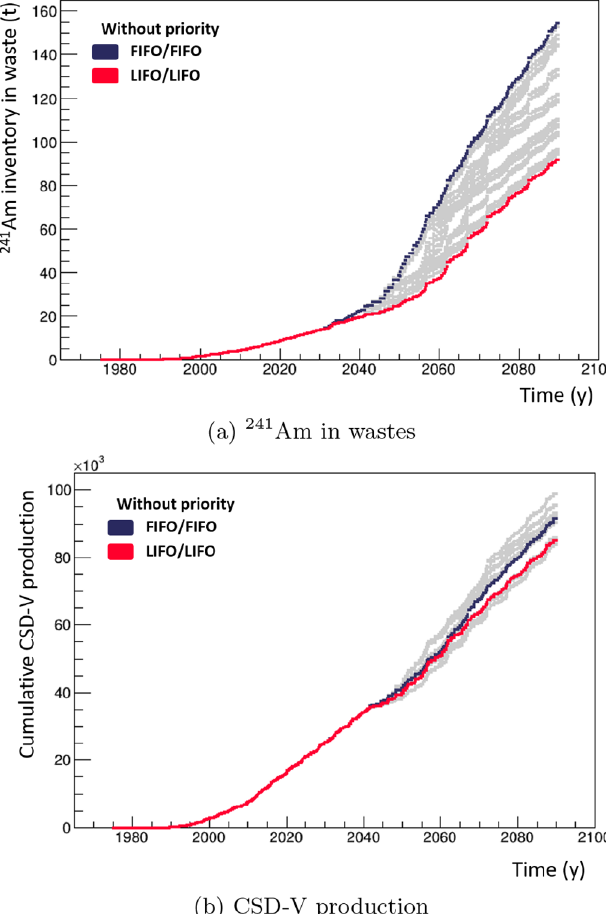
Fig. 10. Highlight of without priority trajectories regarding 241 Am inventory in wastes and CSD-V